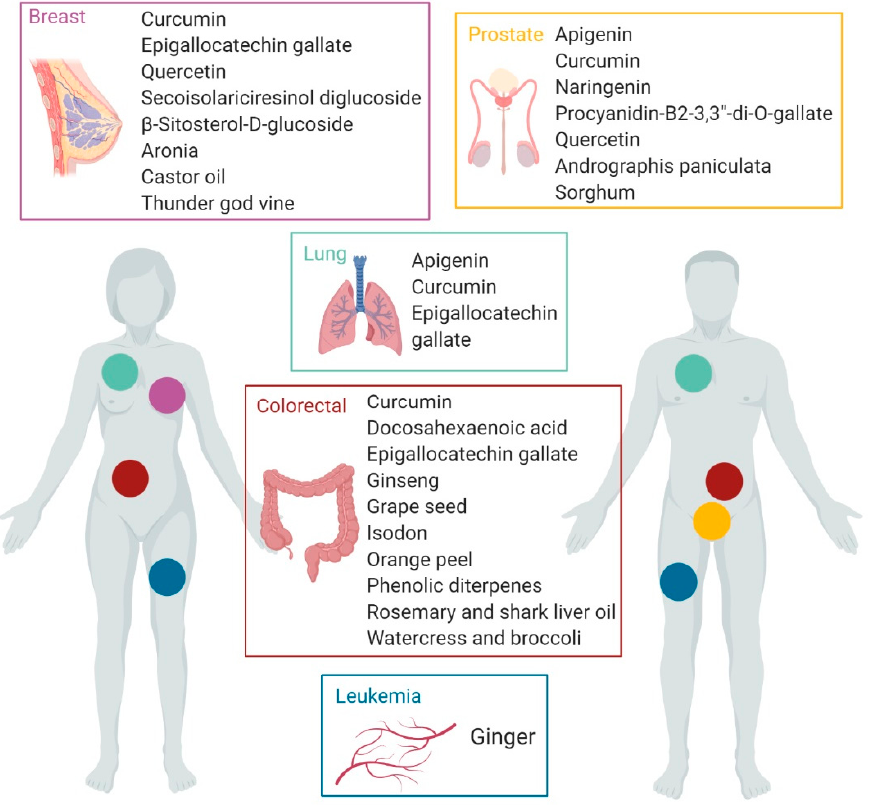
Figure 2. Bioactive foodstuffs and natural extracts with proven effects in cancer treatment. (created with BioRender).